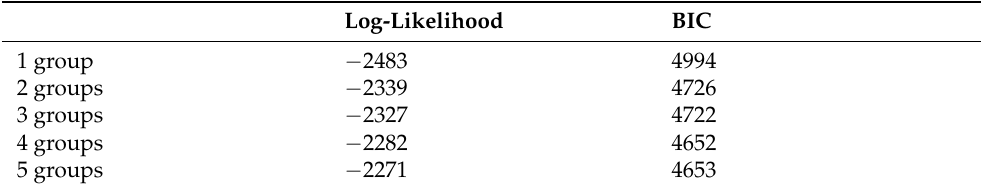
Table 3. Model fit evaluation information.